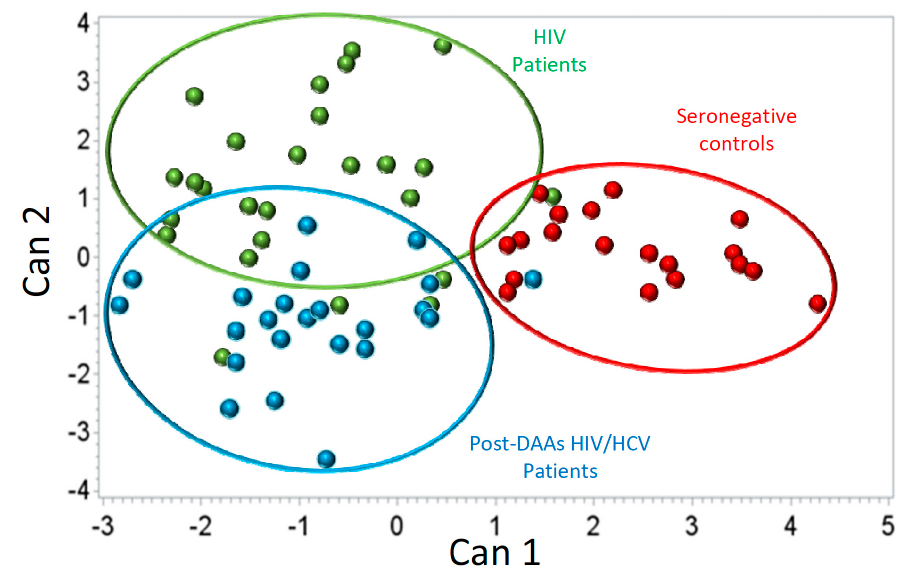
Figure 5. Box-plots showing differences in the level of expression for different CD8 T-cell subsets between seronegative controls (white boxes), HIV monoinfected patients (light-grey boxes) and post-DAAs HIV/HCV coinfected patients (dark-grey boxes). p -values for the comparison between monoinfected and coinfected patients are shown. An asterisk (*) indicates significant ( p < 0.05) difference compared to seronegative controls by Mann-Whitney U test.